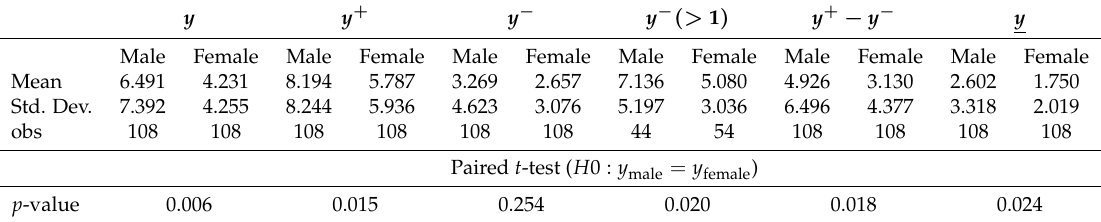
Table 2. Average offers and threshold with gender paired t